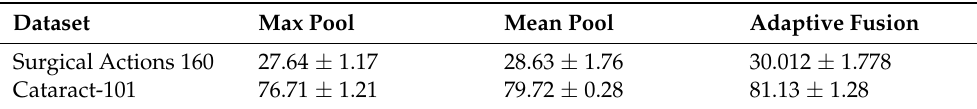
Table 3. mAP (averaged over aforementioned splits) of different feature pooling strategies on two datasets under the CB-SVR system. Dataset Max Pool Mean Pool Adaptive Fusion Surgical Actions 160 27.64 ± 1.17 28.63 ± 1.76 30.012 ± 1.778 Cataract-101 76.71 ± 1.21 79.72 ± 0.28 81.13 ± 1.28